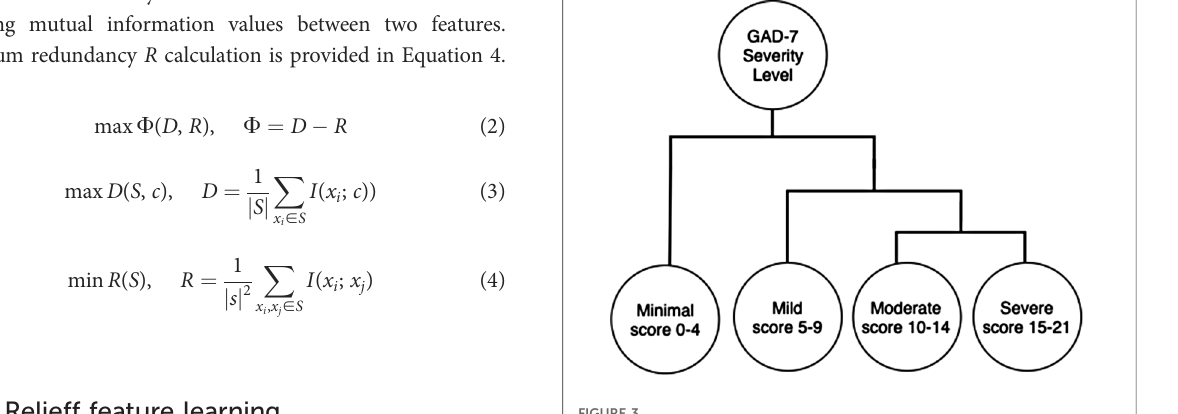
FIGURE 3 Hierarchical depiction of the GAD-7 severity levels with cut-off